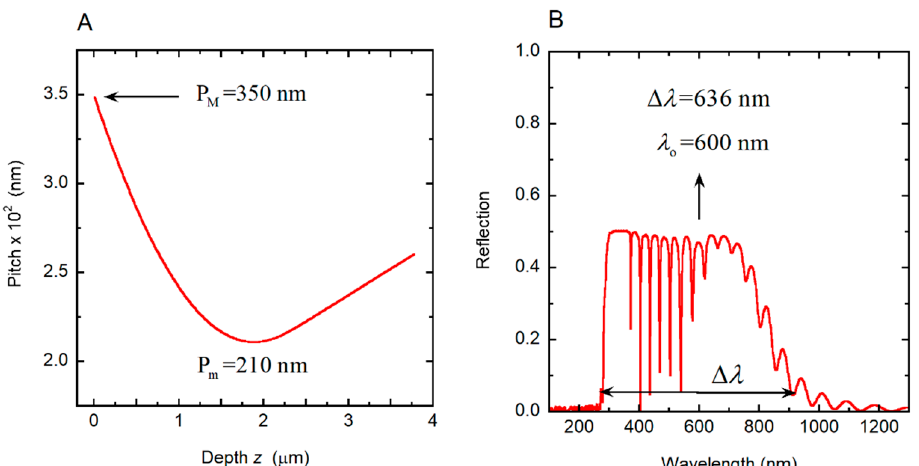
Figure 9. Dependence of pitch on depth z and corresponding reflection spectrum of a chiral structure. ( A ) Quasi-parabolic depth dependence of a helicoidal structure. Maximum ( P M ) and minimum ( P m ) values of the pitches are indicated. ( B ) Reflection spectrum of the structure by assuming normally incident non-polarized light. The reflection band is centered at λ o = 600 nm, and its width is Δ λ = 636 nm.